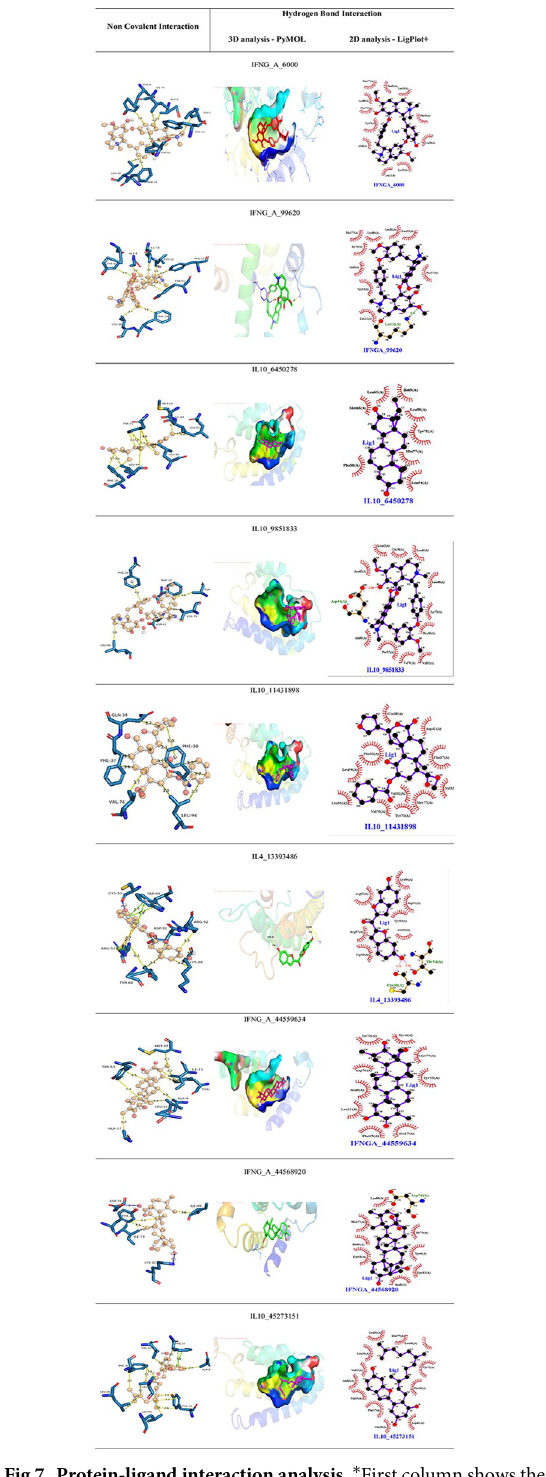
Fig 7. Protein-ligand interaction analysis. * First column shows the nonbonded interactions of the protein-ligand complexes where the ligand is represented as a ball and stick model and the protein predefined in the PLIP software; the distance between the interacted amino acid residues of the protein and the ligand is mentioned. The second column shows the hydrogen bond interactions in three-dimension using PyMOL where HBonds were measured, and without HBonds, the binding pocket was shown on the surface. The third column shows the hydrogen bond interactions in two-dimension using LigPlot+. https://doi.org/10.1371/journal.pone.0282263.g007 PLOS ONE | https://doi.org/10.1371/journal.pone.0282263 March 29,